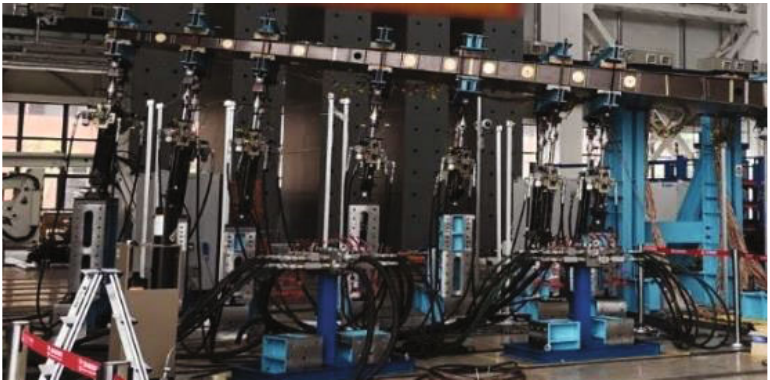
Figure 15: Static load experiments of wing